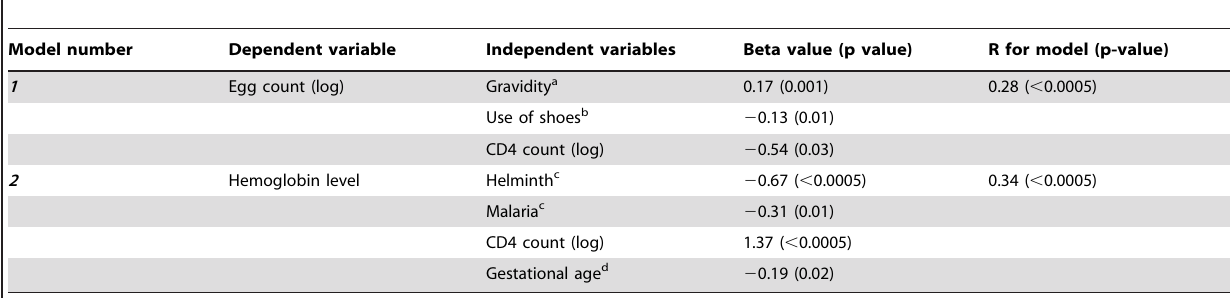
Table 5. Multiple regression models for determinants of helminth egg count and hemoglobin level.